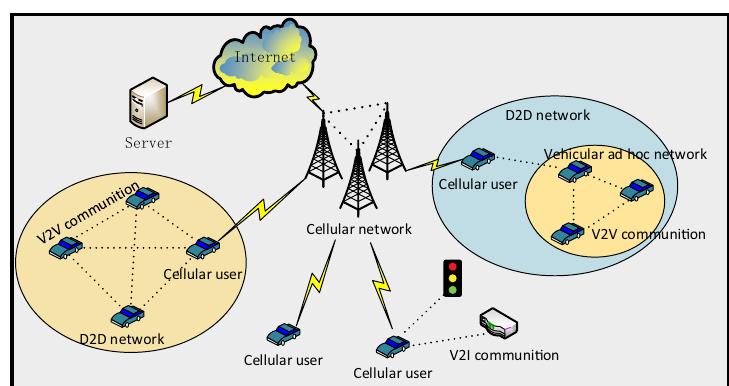
Figure 4 Integrated vehicular networks